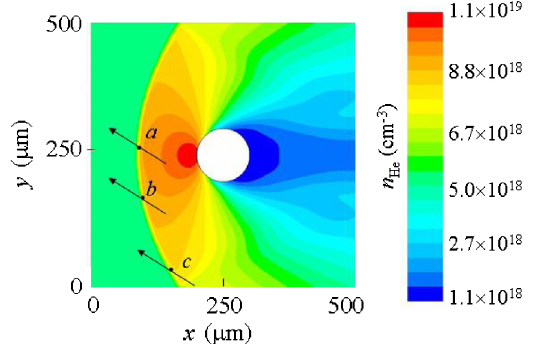
FIG. 3. The density contour 500 ns after inserting the cylinder into the supersonic helium gas flow, corresponding to the last snapshot of velocity shown in Fig. 2. Arrows indicate laser propagation